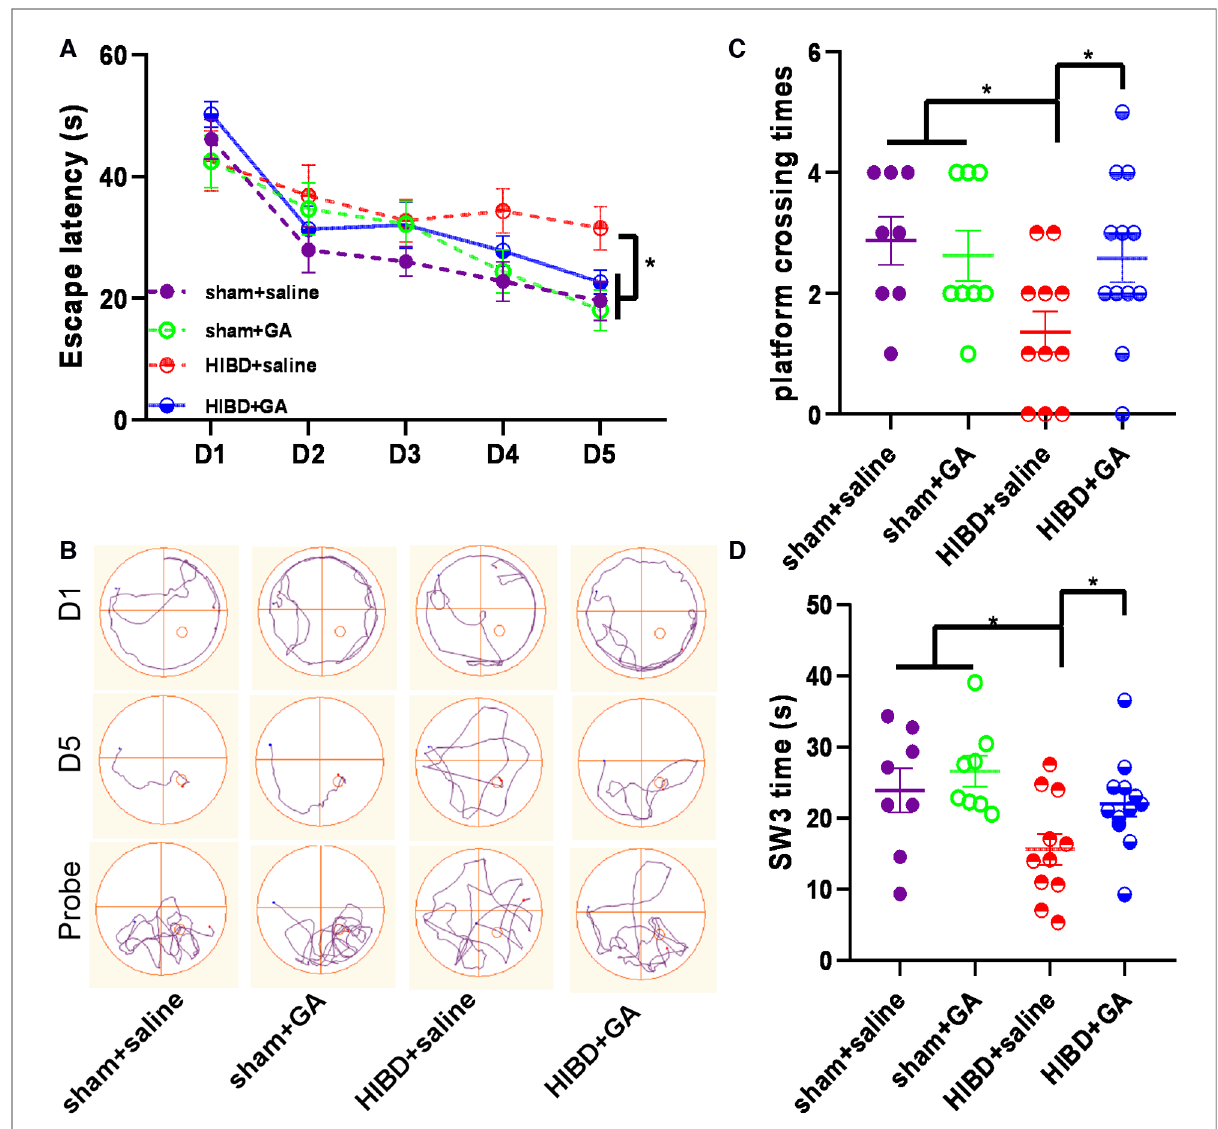
FIGURE 7 Ga improves the learning and memory of HIBD rats. MWM test consists of 1 day of adaptive trials and 5 days of hidden platform trials, plus a probe trial 24 h after the last hidden platform trial. Animal movement was tracked and recorded by ANY-maze tracking software (sham+saline, n =8; sham+GA, n =8; HIBD+saline, n =11; HIBD+GA, n =12). (A ) In hidden platform tests, rats were trained with 4 trials per day for 5 days. GA-treated HIBD rats showed a shorter latency to escape onto the hidden platform on fi fth days compared with the saline-treated HIBD rats. (B ) Tracks of the rat movement in MWM test on different days. In the probe trial, the number of crossing platforms (C ) and the time spent in the platform quadrant (D) of GA-treated HIBD rats were signi fi cantly more than the rats in saline-treated HIBD group. Data are presented as mean±SEM. * P